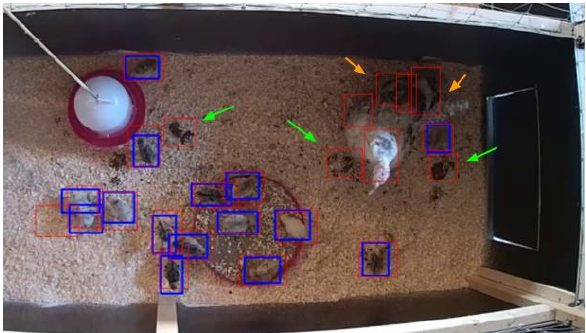
Figure 8. An example of the detections in sequence 3. Green arrows indicate dirt on the floor. Orange arrows indicate black feathers on the tail of the chicken. ©IPI, TiHo Hannover